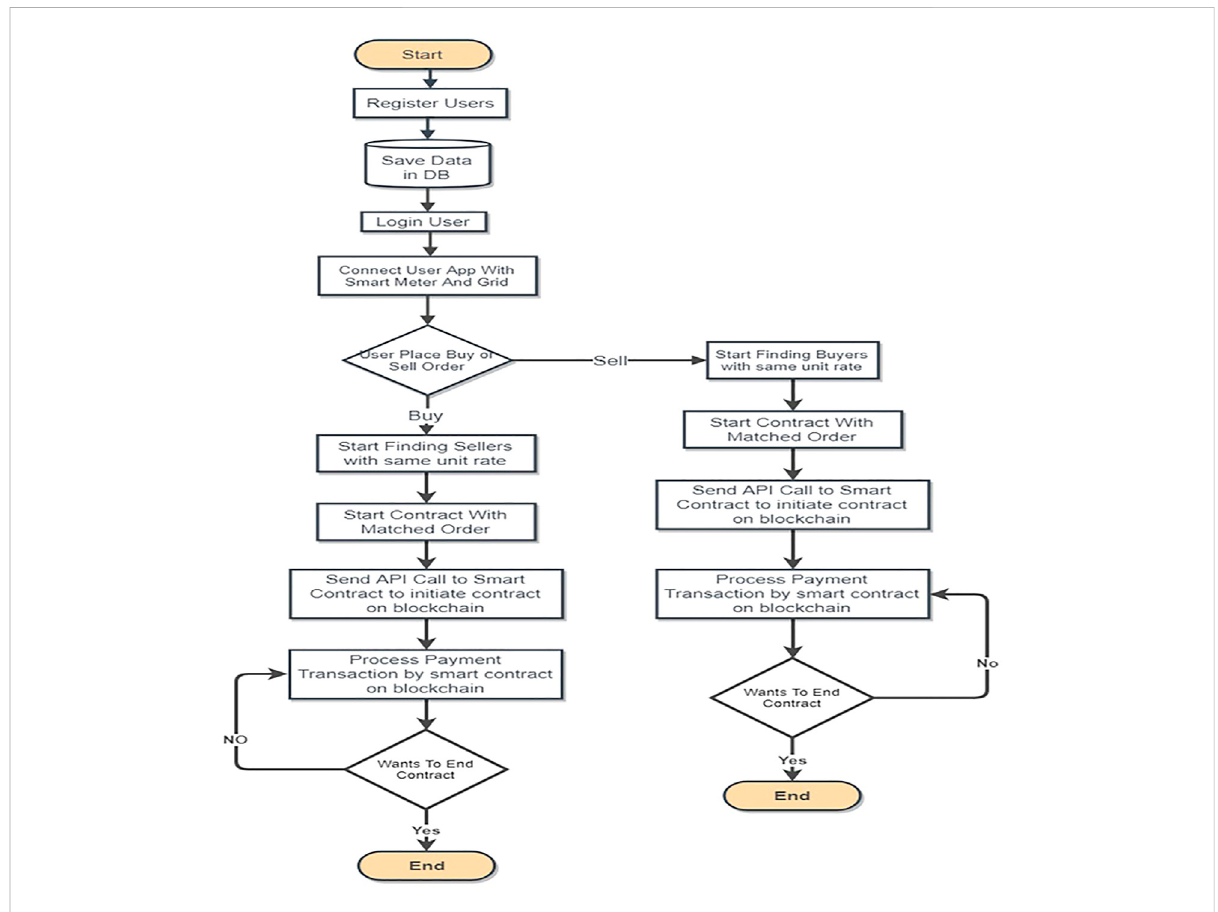
FIGURE 10 Flow chart of the android application.